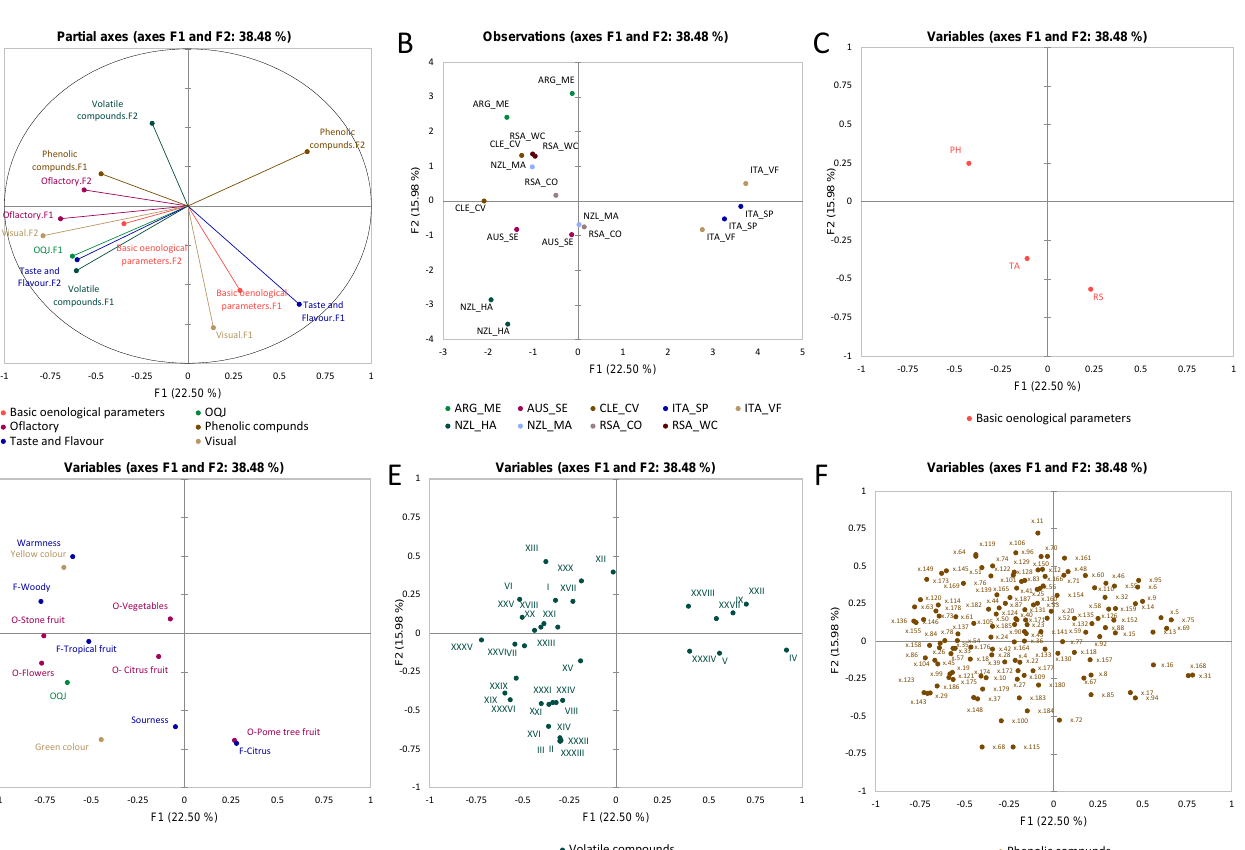
Figure 3. MFA for the Chardonnay dataset. ( A ) shows the partial axes for the first 2 compo- nents and the different datasets used in the computation, ( B ) shows the observation plot, and ( C – F ) shows basic oenological variables, sensory analysis variables, aroma compounds, and phe- nolic compounds, respectively. Identified volatile compounds: I = ethyl acetate, IV = 4-amino-1- butanol, VIII = ethylamine, IX = 2-pentanol-3-methyl-, X = butyl lactate, XI = 1-propanol, 3-amino-, XII = 2,3-butanediol, XIII = propanoic acid, 2-hydroxy, ethyl ester or methyl ester, XIV = octanoic, ethyl ester, XV = acetic acid, XVII = 2,4-hexadienoic acid, ethyl ester, XXII = decanoic acid, ethyl ester, XXIII = butanedioic acid, diethyl ester, XXV = naphthalene, 1,2-dihydro-1,1,6-trimethyl-, XXVI = acetic acid, 2-phenylethyl ester, XXVII = hexanoic acid, 2-phenylethyl ester, XXIX = benzene butanal, XXX = phenylethyl alcohol, XXXI = sorbic acid, XXXIII = naphthalene, decahydro-4a-methyl- 1-methylene-7-(1-methylethylidene), XXXIV = n-decanoic acid, XXXV =